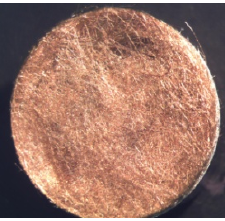
Figure 3. Digital images of nonwoven disc.